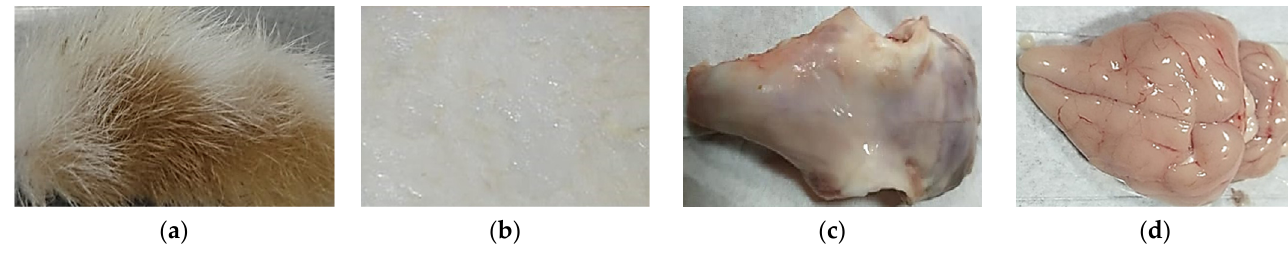
Figure 1. The studied tissue samples: skin before ( a ) and after ( b ) shaving, skull ( c ), and brain ( d ).